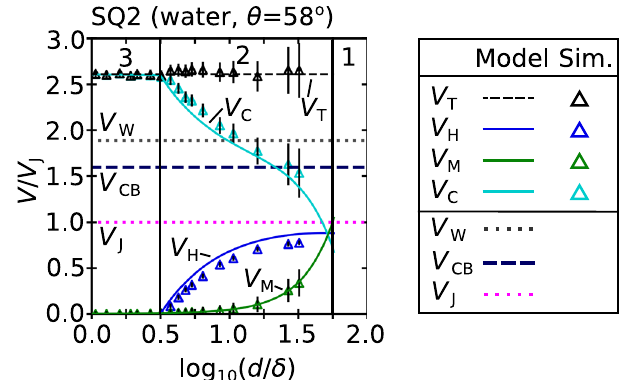
Fig. 4 The liquid volume raised against gravity upon variation of the plate separation. Predicted volumes from the Dual-Rise model are compared for the simulated, square-pillared system SQ2 with water as the rising liquid (capillary length λ c = 2.7 mm) and θ = 58°. The total volume V T is shown, which is decomposed into the individual contributions from: capillary rise V C , hemiwicking V H , and the meniscus V M . The ± 1 post error bars are shown, and the plate separation d is shown relative to the roughness depth δ . Also shown are the capillary volumes calculated using: Jurin ’ s Law V Wenzel approximation V W , and the Cassie-Baxter approximation V CB . The three regimes of equilibrium rise are demarked and labelled 1 – 3.